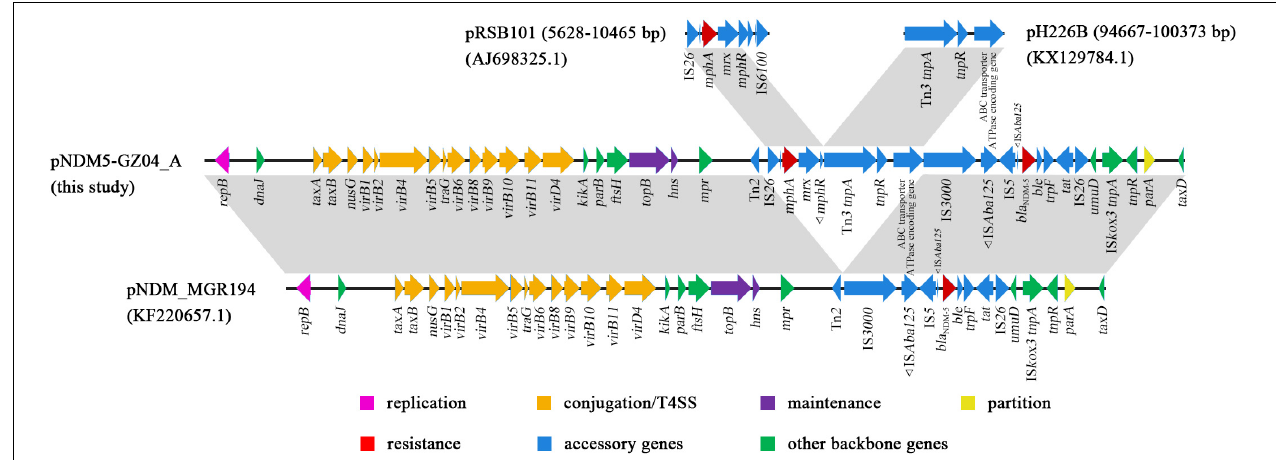
FIGURE 3 | The comparative schematic diagram of plasmids pNDM5-GZ04_A, pNDM_MGR194, and fragments of pRSB101 and pH226B. The open reading frames are denoted by arrows. Regions with > 99% identity among different plasmids are indicated by light gray.